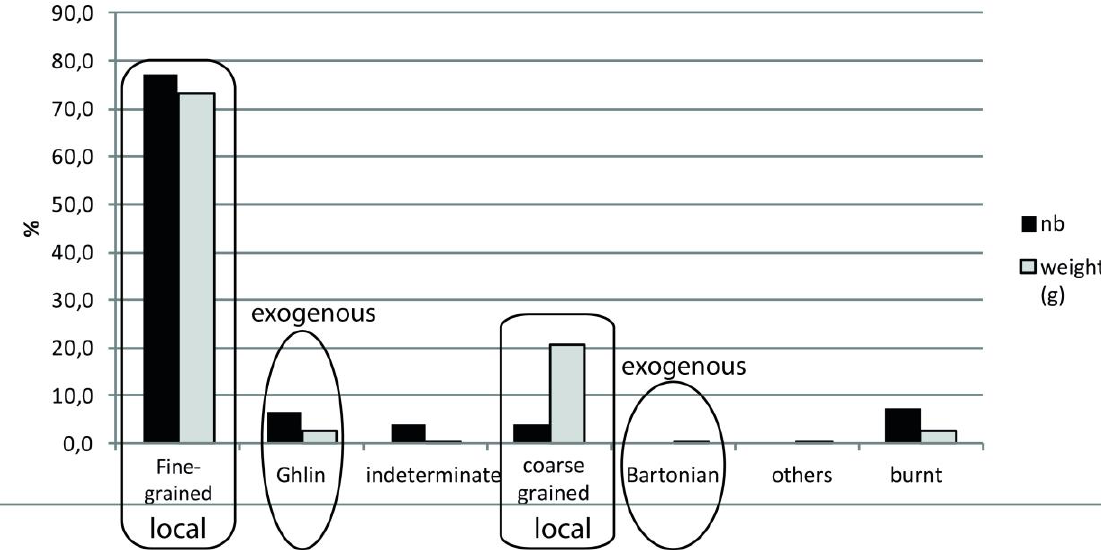
Figure 4. Siliceous raw materials spectrum of Vaux-et-Borset, from the two pits excavated in 1998 which delivered 6968 pieces (62